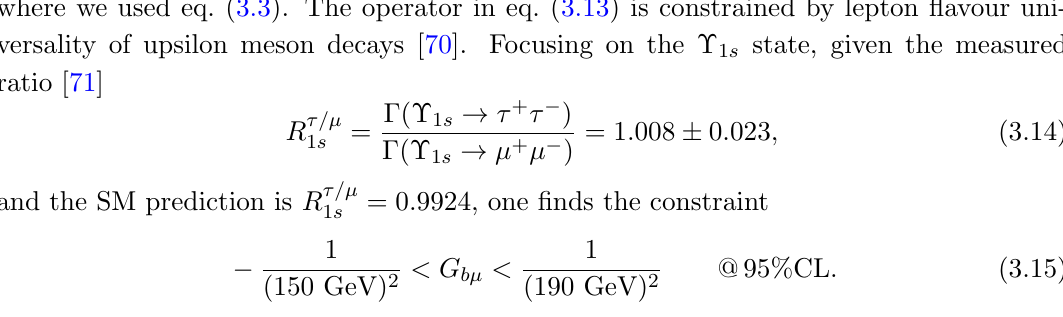
Figure 2 . The parameter space in the ( g (cid:22)(cid:22) ; m Z 0 ) plane compatible with R (cid:13)avour constraints (white). We show the recent B s mixing constraints (light blue), the trident bounds (orange), the Z ! 4 (cid:22) limits (pink) as well as the expected limits from (cid:22) ! e(cid:13) for several values of j V 0 j 21 (black eL